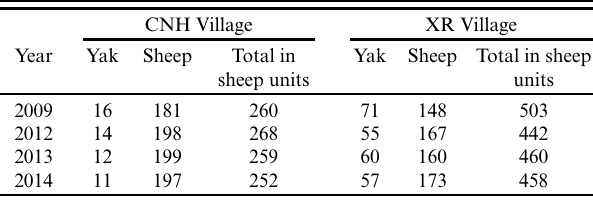
implementation of the quota